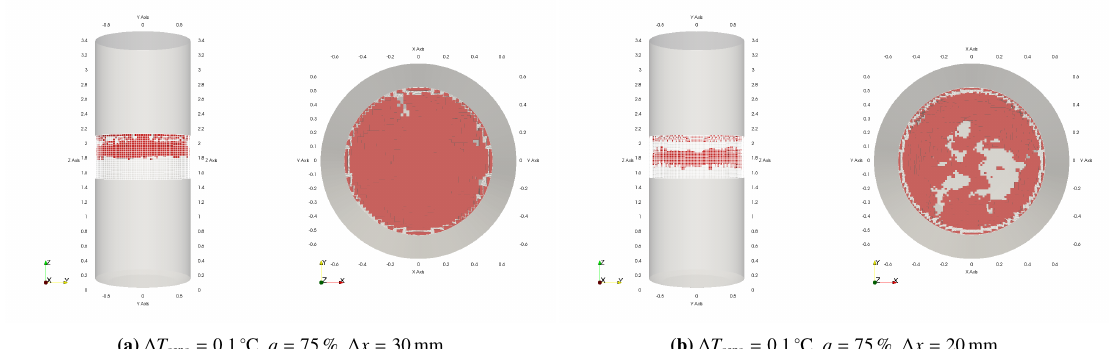
Figure 8. Post-processing output showing suitable sensor locations (red) for the large tank case study assessed for different ∆ x (( a ): 30mm; ( b ): 20mm) and constant threshold values ( ∆ T sens = 0.1 ◦ C and q =